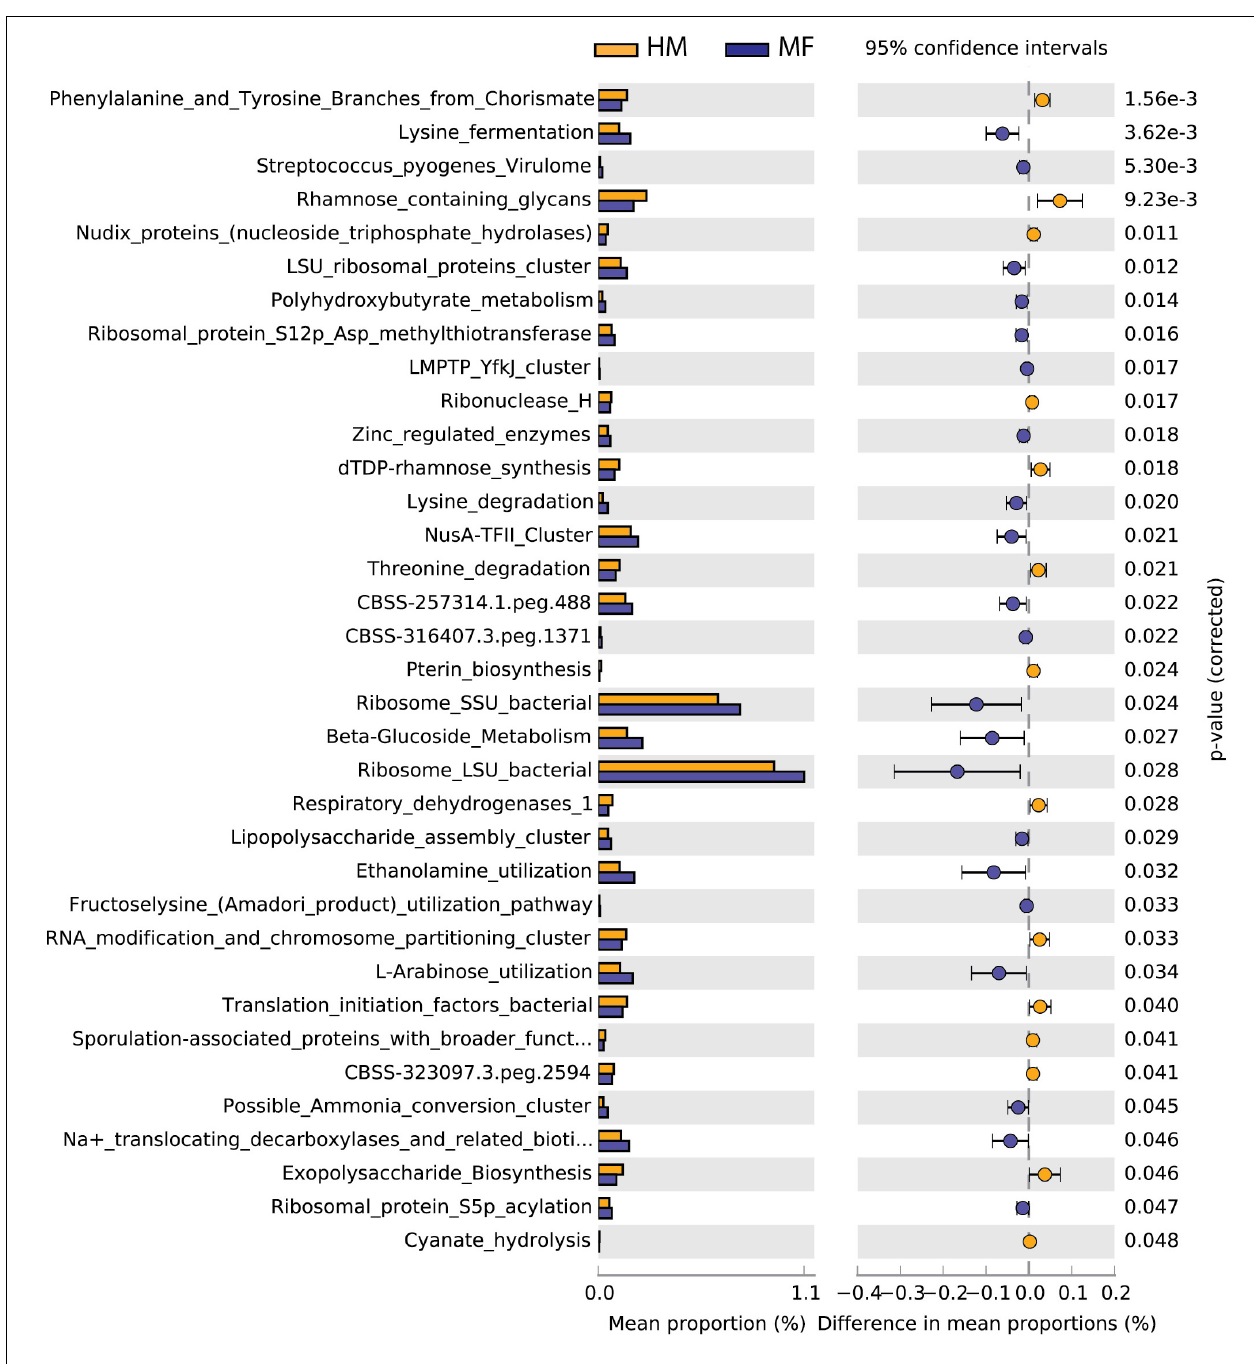
FIGURE 2 | Significant differences in predicted metabolic functions ( P < 0.05) for cecum bacterial gene profile detected at PND 21 in male piglets fed with HM or milk formula MF from day 2 until day 21 of